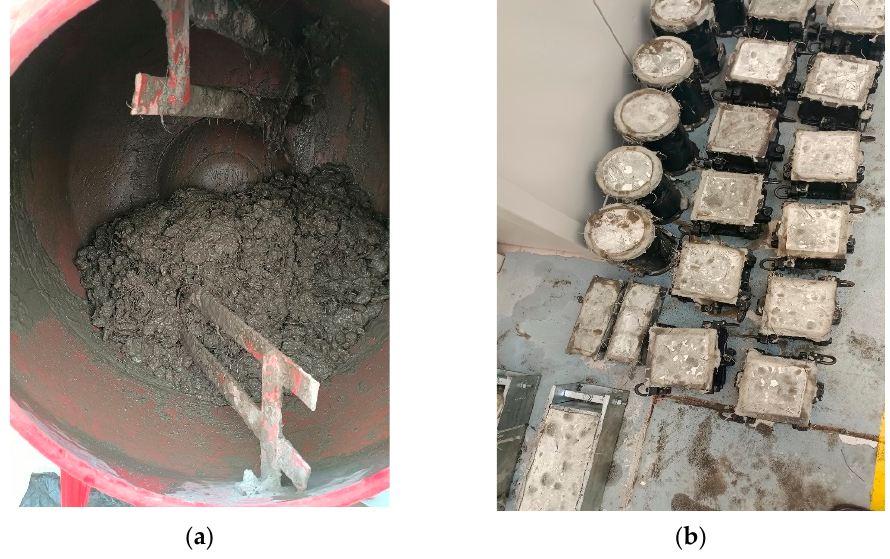
Figure 3 . Samples preparations . ( a ) Mixing, ( b ) Hardened samples [4] . Figure 3. Samples preparations. ( a ) Mixing, ( b ) Hardened samples